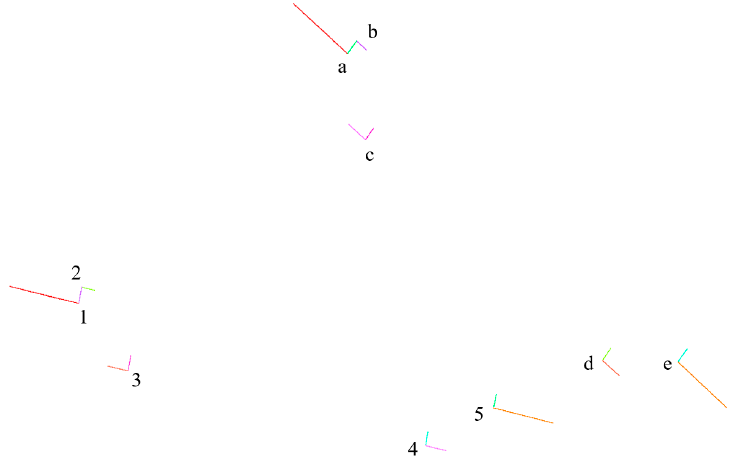
Figure 21. Line segments that can be matched; 1, 2, 3, 4, and 5 correspond to a, b, c, d, and e.